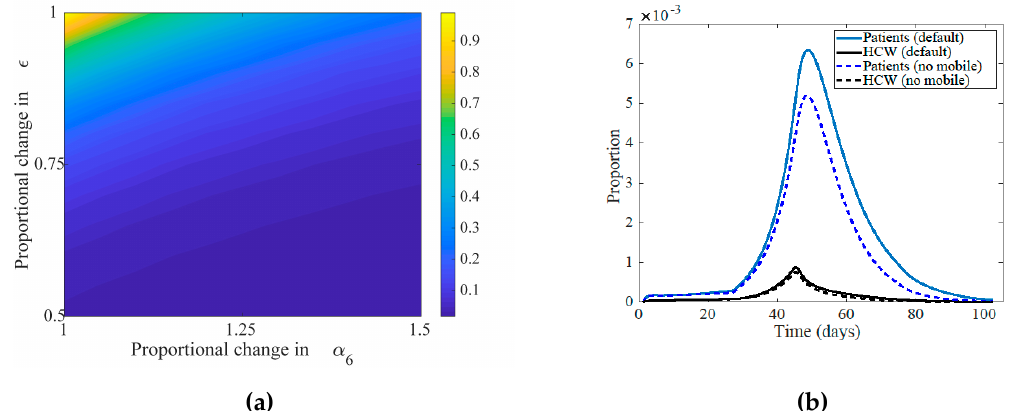
Figure 5. The e ff ect of control measures imposed on patients versus on HCWs. ( a ) Relative total size of epidemics of patients, HCWs, and mobile HCWs’ to the maximum size of epidemic is calculated for increased rate of isolation ( α 6 ) versus decreased transmission from HCWs to patients due to infection control measures like using masks and gloves ( (cid:15) ). It indicates that isolation rate is more e ffi cient than the relative reduction in infectivity due to protective equipment; with smaller relative values attained as ( (cid:15) , α 6 ) gets closer to the (0.5,1.5). ( b ) The sizes of the epidemics of patients and HCWs for the fitted values versus when the HCWm are removed from the system.